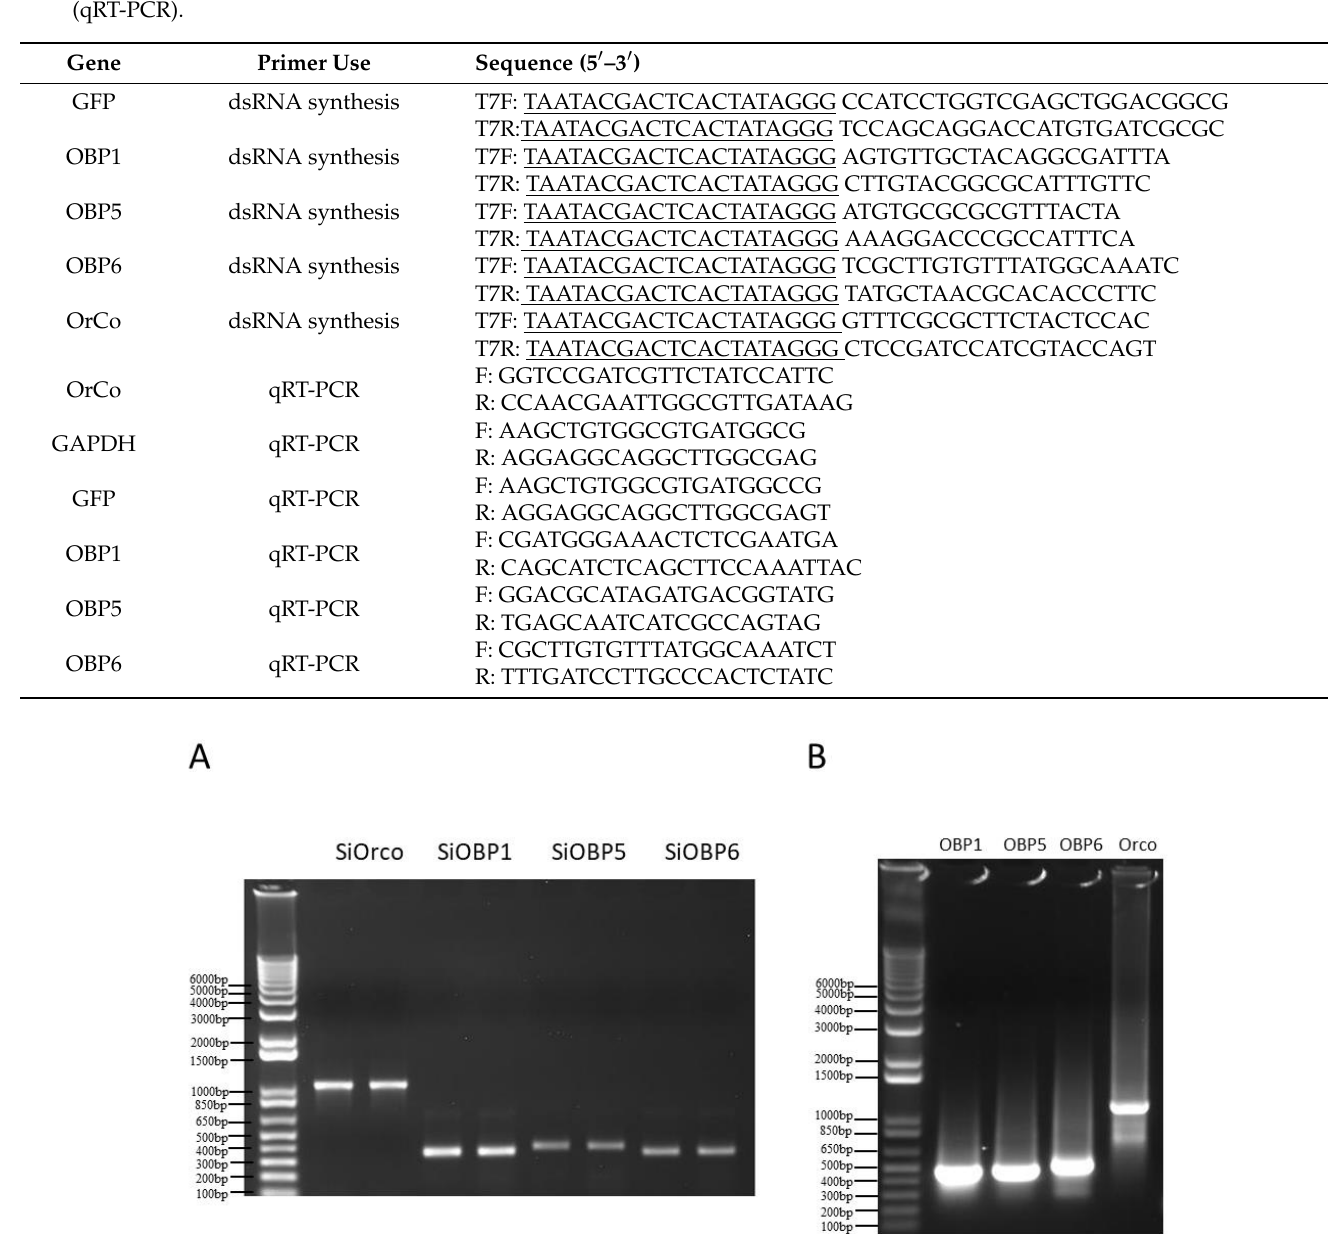
Table 1. A list of the primer sequences used for the dsRNA synthesis and real-time quantitative reverse transcriptase PCR (qRT-PCR).